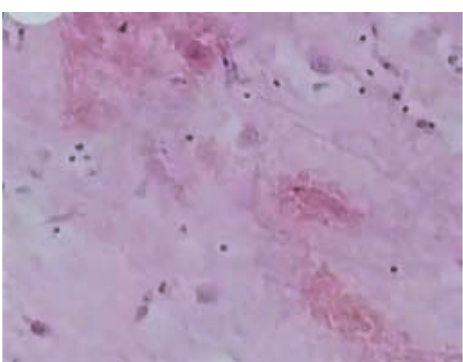
Fig. 1 : Presence of D shaped, closed, dark black colored stigmal plates with radially arranged spiracles